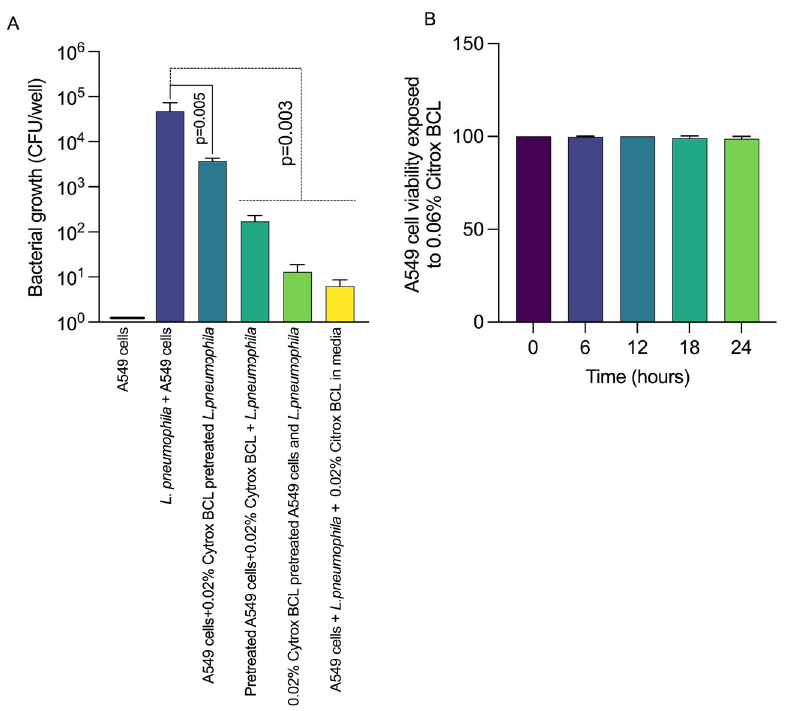
Figure 1. The impact of Citrox CBL on growth and survival of L. pneumophila at concentrations of 0.02–0.06%. The MIC concentrations tested are indicated on the graphs in order to establish the sub ‐ inhibitory concentration for further investigations. The experiments were performed in triplicate and on three separate occasions. In order to quantify the growth, the absorbance was measured at 600 nm every 3 h for 36 h.